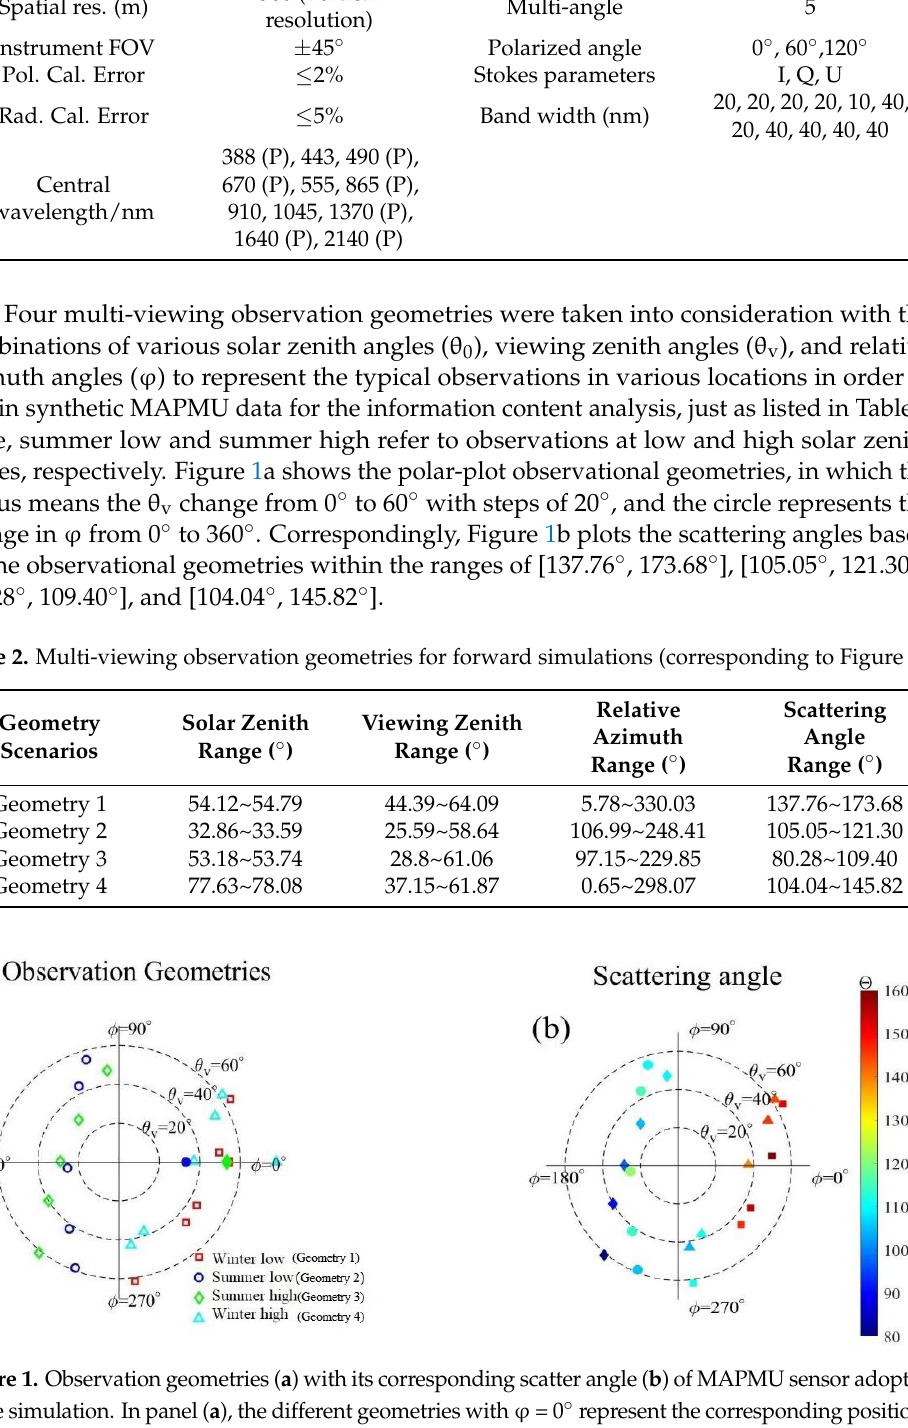
Figure 1. Observation geometries (a) with its corresponding scatter angle (b) of MAPMU sensor adopted in the simulation. In panel ( a ), the different geometries with φ = 0° represent the corre- sponding positions of the sun for summer low, summer high, winter low, and winter high scenarios,